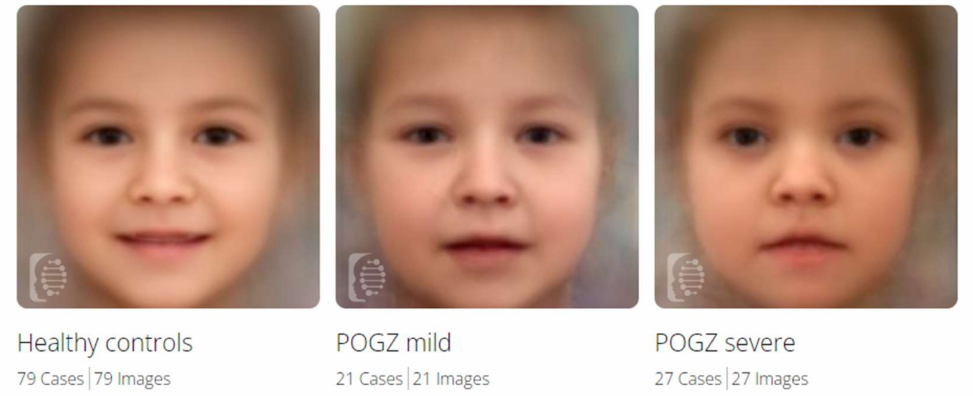
Figure 4. Composite images from Face2Gene for POGZ patients with mild and severe phenotype and healthy